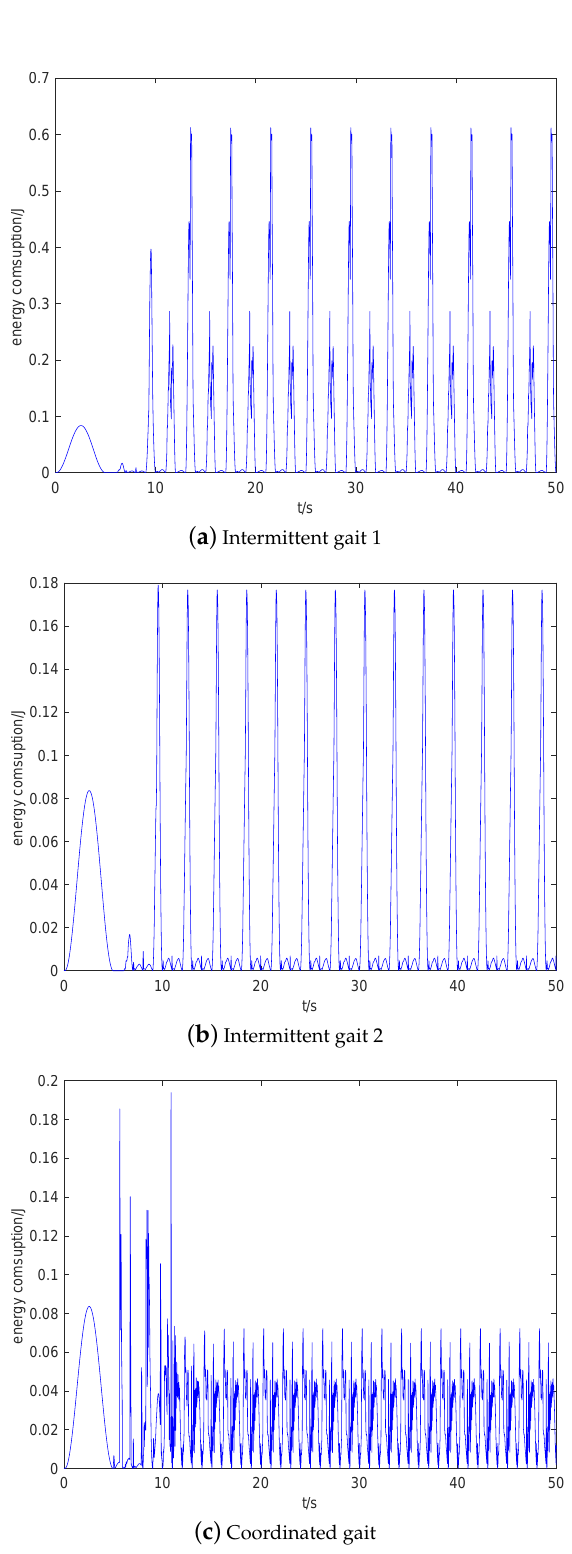
Figure 14. Comparison of energy consumption of three static